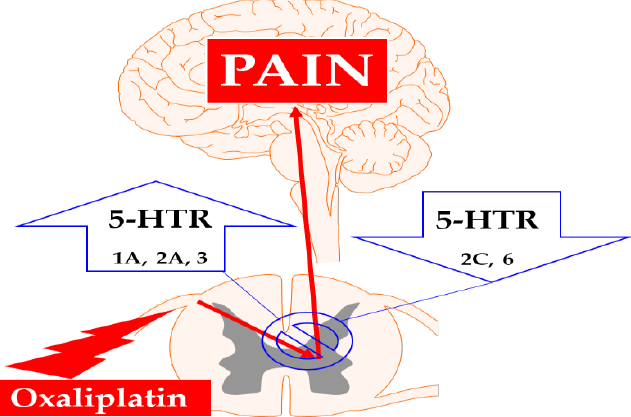
Figure 1. The involvement of spinal serotonergic receptors in the alleviation of oxaliplatin-induced neuropathic pain. Oxaliplatin administration increases the transmission of nociceptive signals from the primary afferent fibers to the brain (red). Activation of spinal 5-HT 1A, 2A, and 3 receptors and inhibition of spinal 5-HT 2C and 6 receptors could reduce allodynia induced by oxaliplatin (blue). 5-HTR; 5-HT receptors.